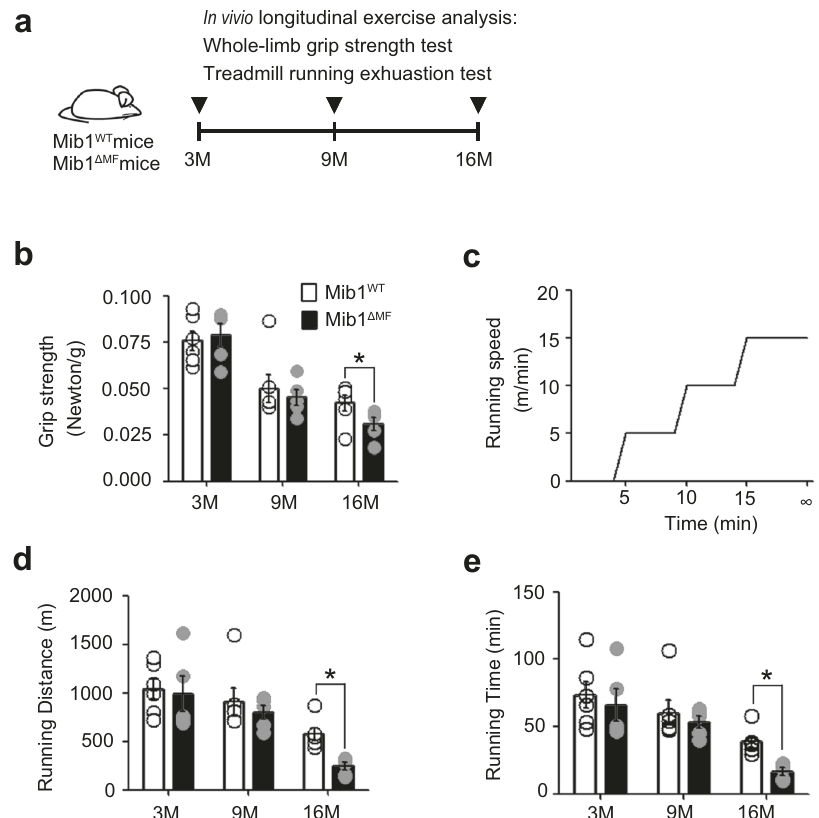
Fig. 3 Age-associated impaired muscle function in Mib1 Δ MF mice. a To track changes in skeletal muscle function with age, the longitudinal in vivo muscle function analysis was performed. Mib1 WT and Mib1 Δ MF mice were subjected to exercise analysis (whole-limb grip strength test and treadmill running exhaustion test) at 3, 9, and 16 months. b Whole-limb grip strength at indicated ages. c Scheme of treadmill running. d , e Running distance ( d ) and time ( e ) to exhaustion at indicated ages. Data are presented as means ± s.e.m. Data are shown as representatives of at least three independent experiments. n = 6 and 5 for Mib1 WT and Mib1 Δ MF mice, respectively ( b , d , e ). Two-way ANOVA for ( b , d , e ). * p <